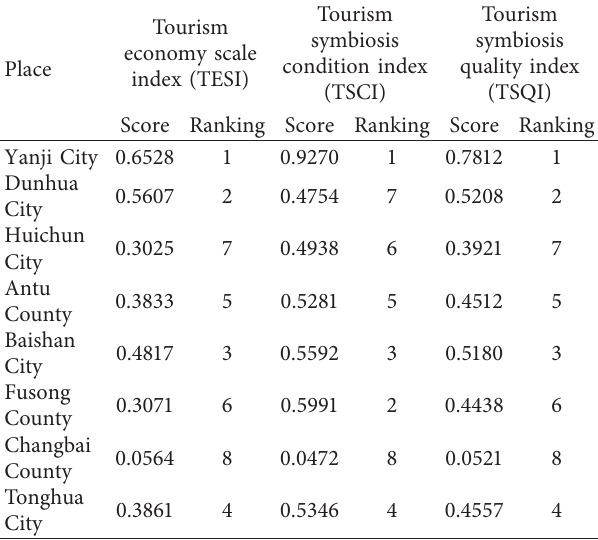
Table 5: Symbiosis unit quality index and